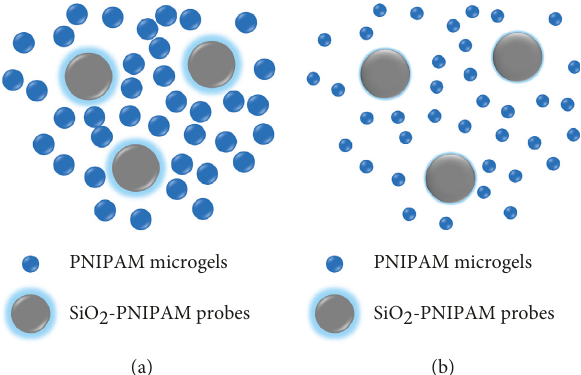
Figure 10: The schematics of the probe particle of SiO 2 -PNIPAM (grey) in the water dispersion of PNIPAM microgels (blue) at the temperature of (a) 20 ° C and (b) 32 °